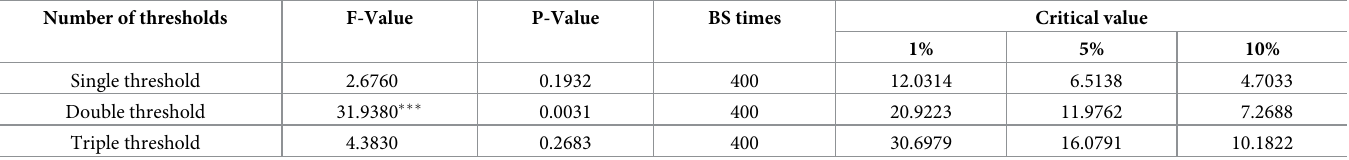
Table 8. The core explanatory variable is the threshold effect of the number of poor